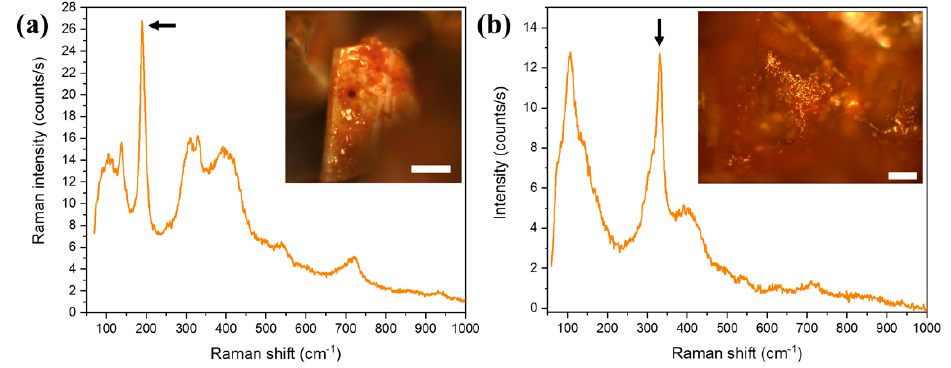
Figure 9. Micro-Raman spectra recorded on AAFC sample: ( a ) showing the peak related to FeCl 3 ; ( b ) showing the peak adscribed to akaganeite phase with Cl. Insets: optical micrographs of the crystals where the spectra were taken. In all cases, the scale bar is 100 µm.